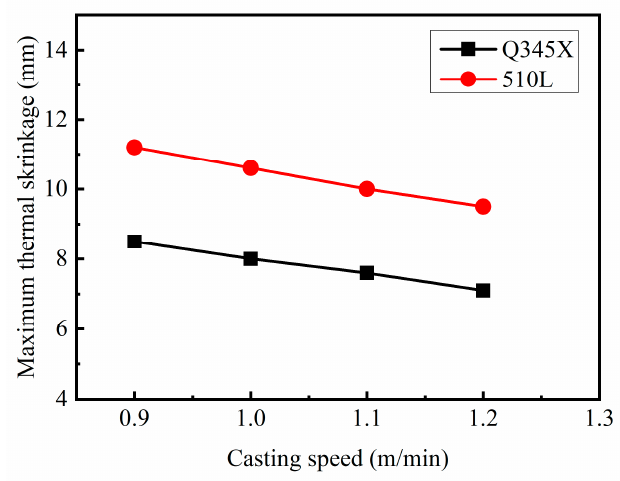
Figure 7. Maximum surface shrinkage of the slab at different casting speeds.